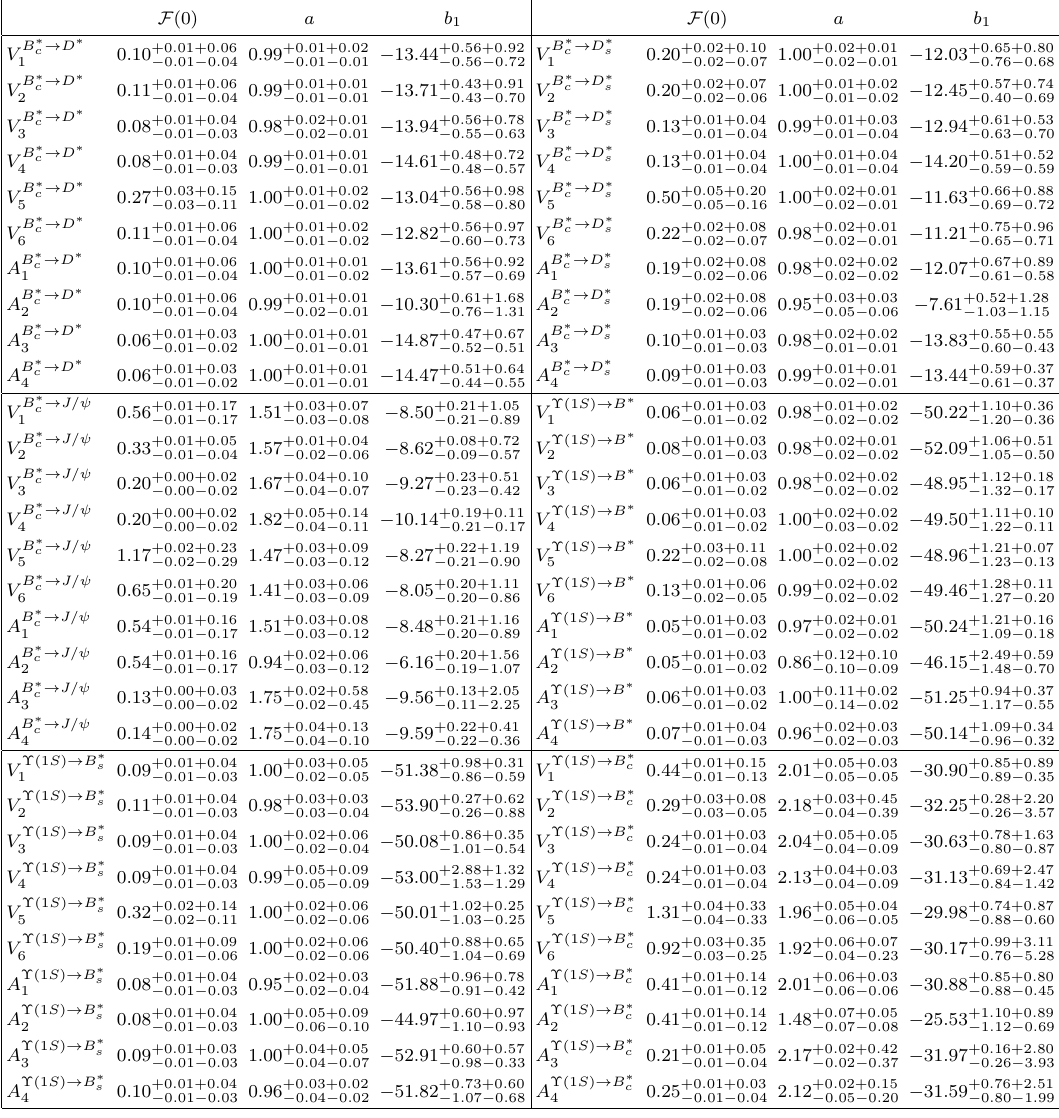
Table 6 . Same as table 4 except for b ! ( q; s; c ) induced B (cid:3) ( B (cid:3) ; B (cid:3) ; B (cid:3) ) transitions. The errors are due to parameters (cid:12) and quark masses only (cf. section s c